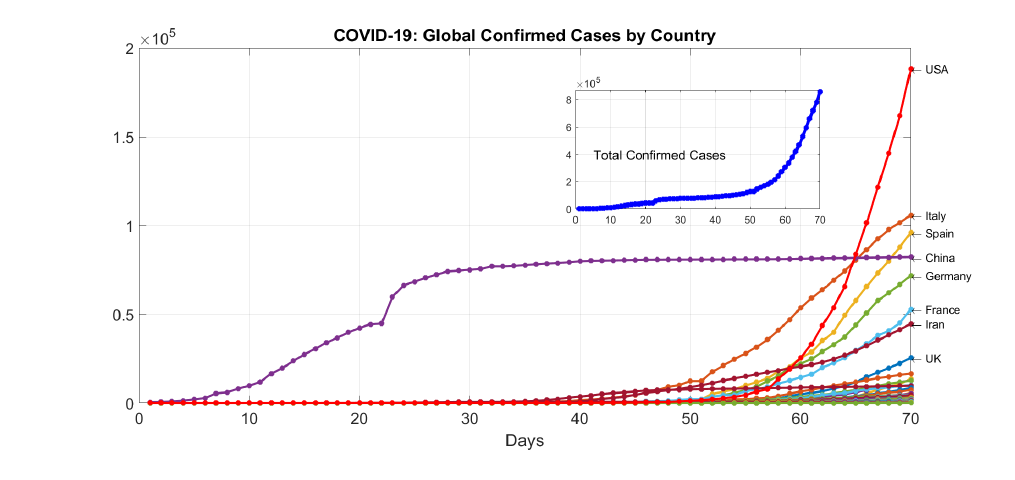
Figure 4. Time series of global confirmed cases of COVID-19 from 22 January to 31 March.